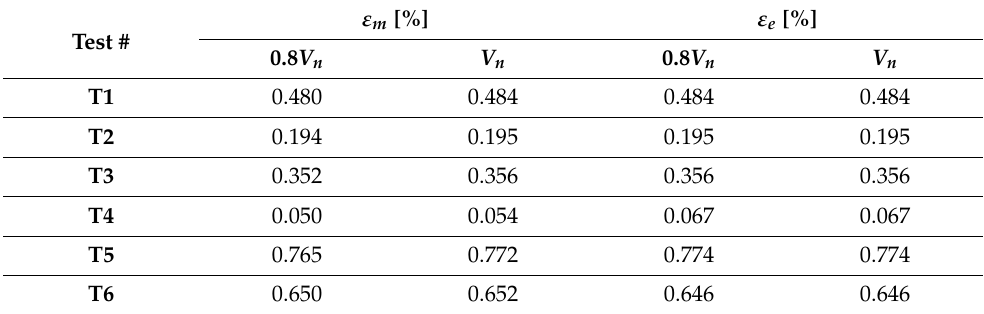
Table 4. Comparison between the measured and the estimated ratio